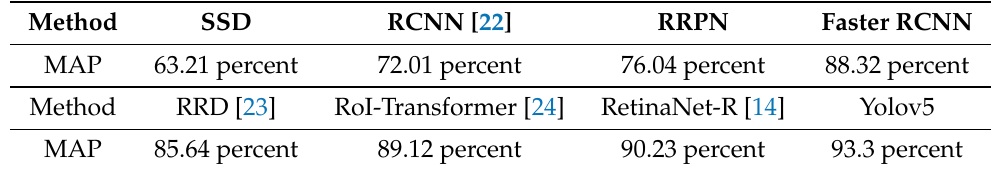
Table 5. Comparison of detection results of different